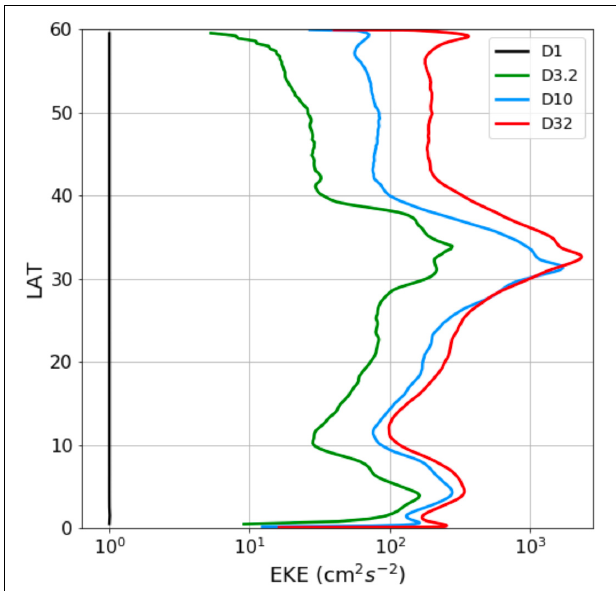
FIGURE 4 | Zonal-averaged EKE (in cm 2 s − 2 ) at the surface from the four experiments.